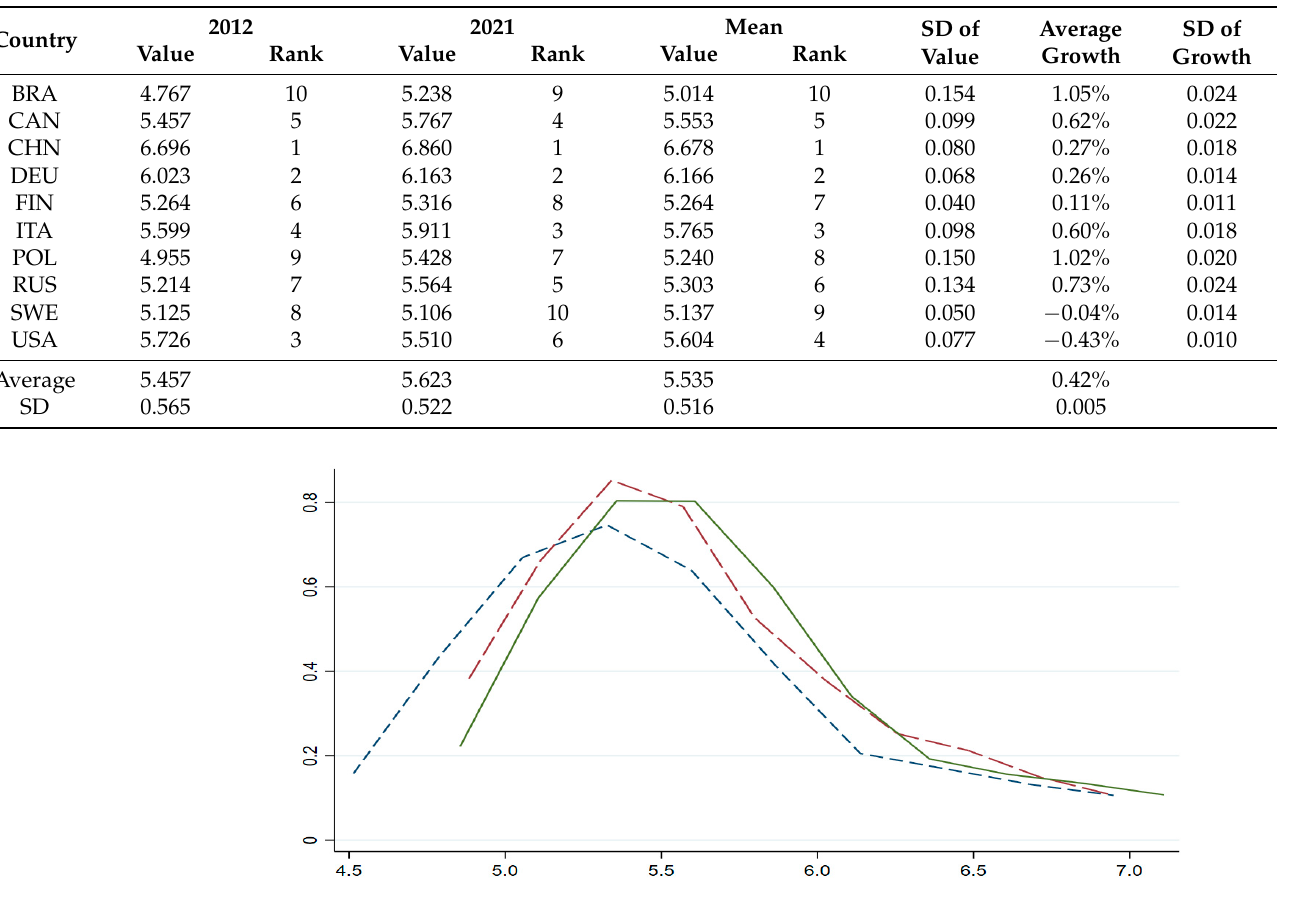
Table 8. The composite index of international competitiveness for all forest products.